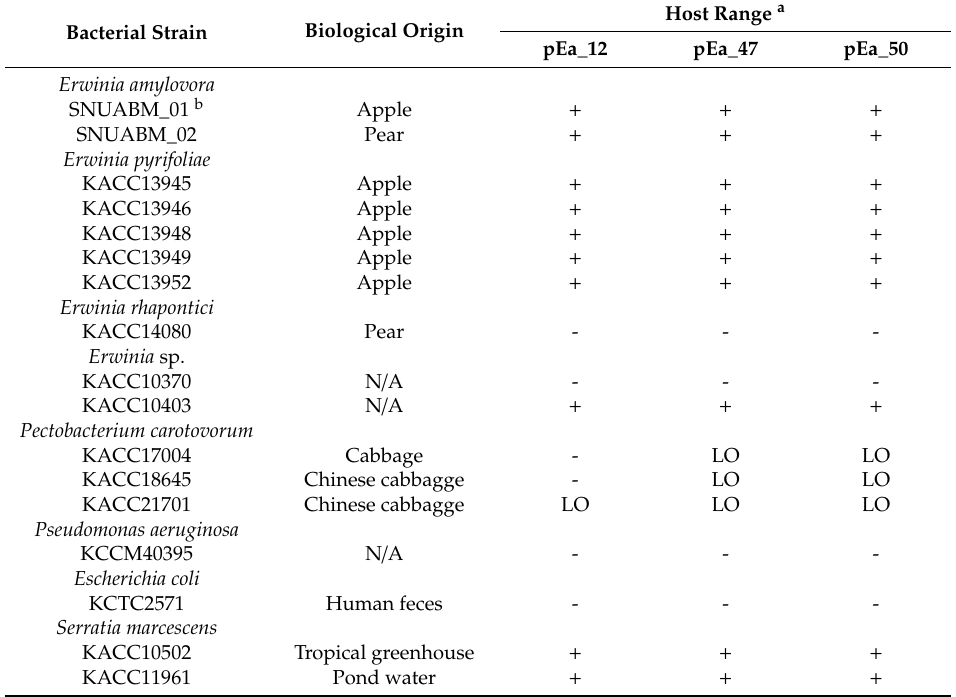
Table 1. Host range of Erwinia phages pEa_SNUABM_12, pEa_SNUABM_47, and